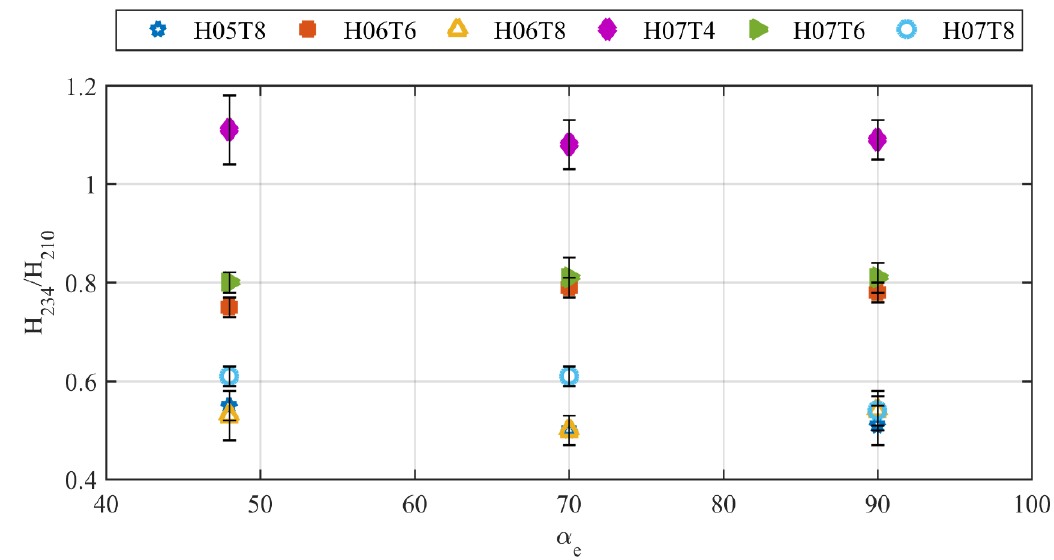
Figure 4. Ratio of mean wave heights close to the wall (H 234 ) and at the toe of the slope (H 210 ) against the extremity angle of the recurve for all test cases.